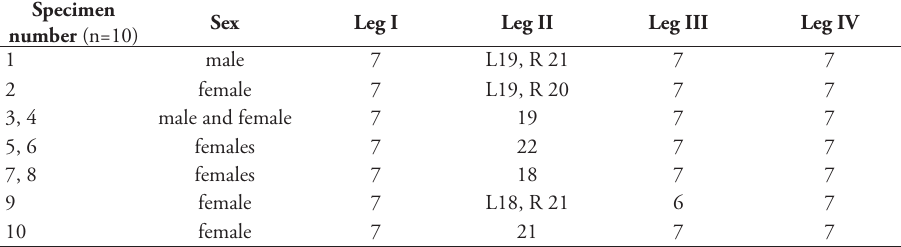
Table 3. Numbers of tarsomeres of on legs of Lobonychium palpiplus Roewer, 1938. L left, R right tarsus. Only one number is given when the specimen is